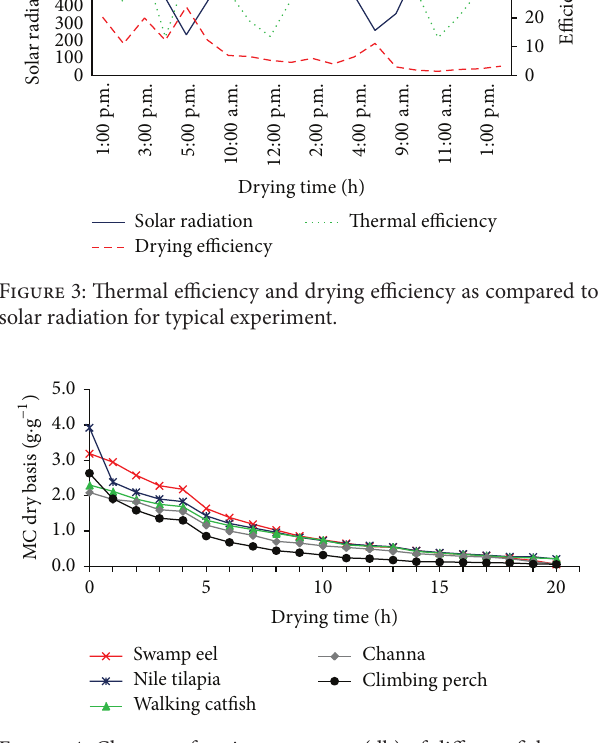
Figure 4: Changes of moisture content (db) of different fish meat samples with drying time for a typical experimental run in solar dryer